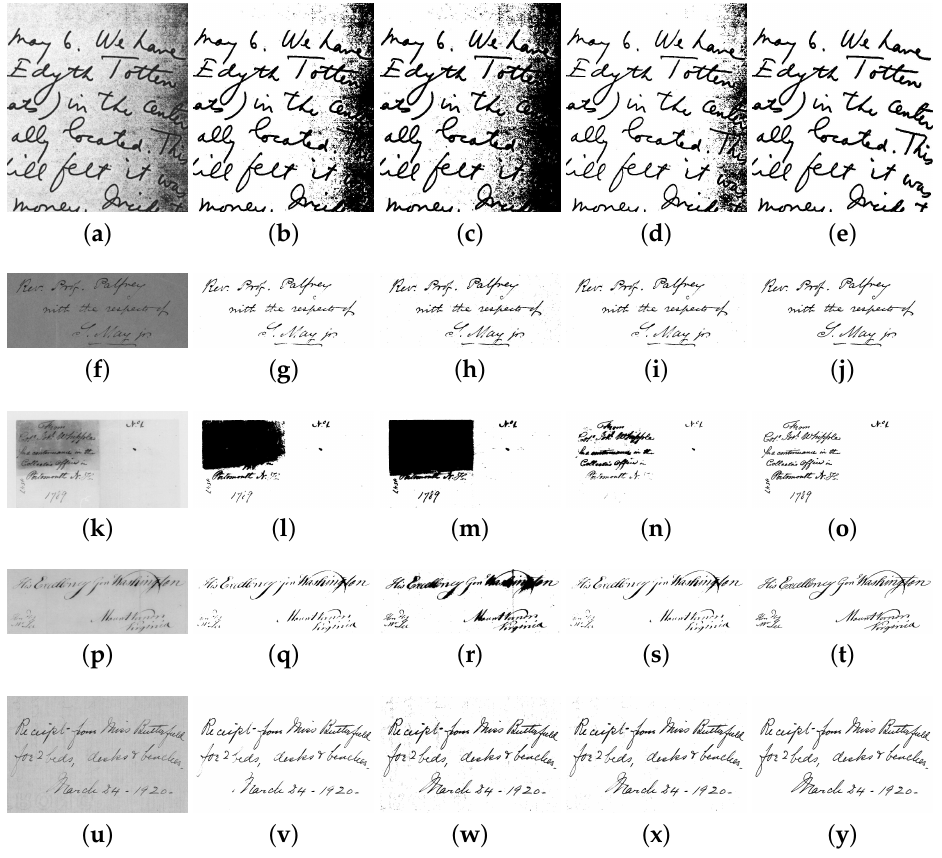
Figure 2. The input images are shown in the first column: ( a ) image 1, ( f ) image 2, ( k ) image 3, ( p ) image 4 and ( u ) image 5. The second ( b , g , l , q , v ), third ( c , h , m , r , w ), and forth ( d , i , n , s , x ) columns are results obtained by Otsu’s, Kittler et al.’s, and FADIT methods, respectively. Images in the last column ( e , j , o , t , y ) are the corresponding ground-truth